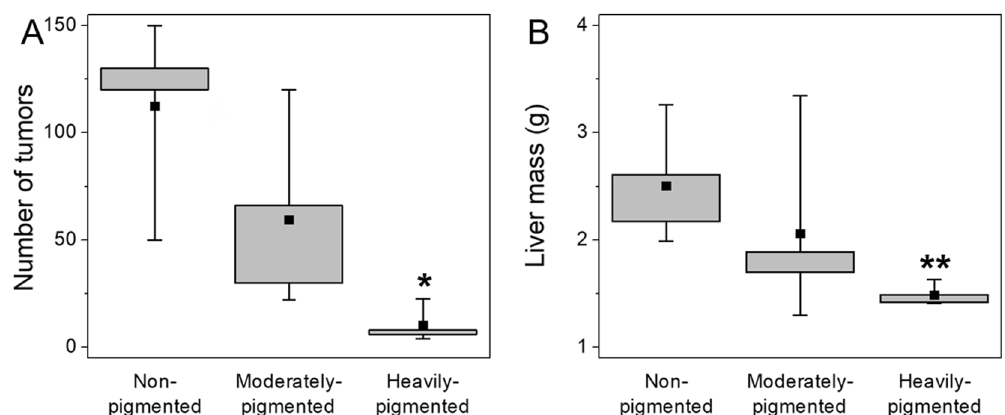
Figure 3. Results obtained from in vivo experiments. Box plots of liver masses ( A ) taken from mice, which had inoculated melanoma cells with different levels of melanin pigmentation followed by box plot of the number of metastatic tumors ( B ) that were visible on the livers during autopsy. Square dots in box plots indicate the median values. * Statistically significant vs. non-pigmented cells ( P < 0.05); ** statistically significant vs. non- pigmented cells ( P <